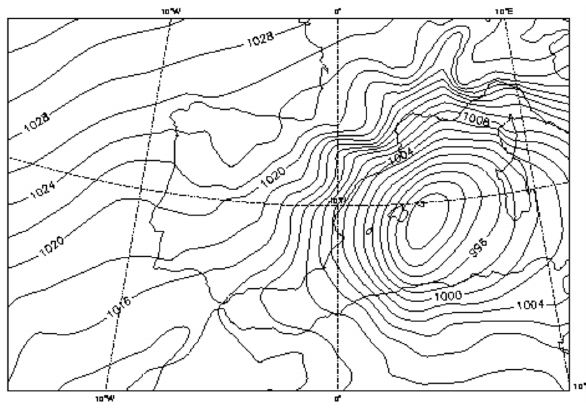
Figure 2. MSP HIRLAM-INM analysis, 11 November 2001 at